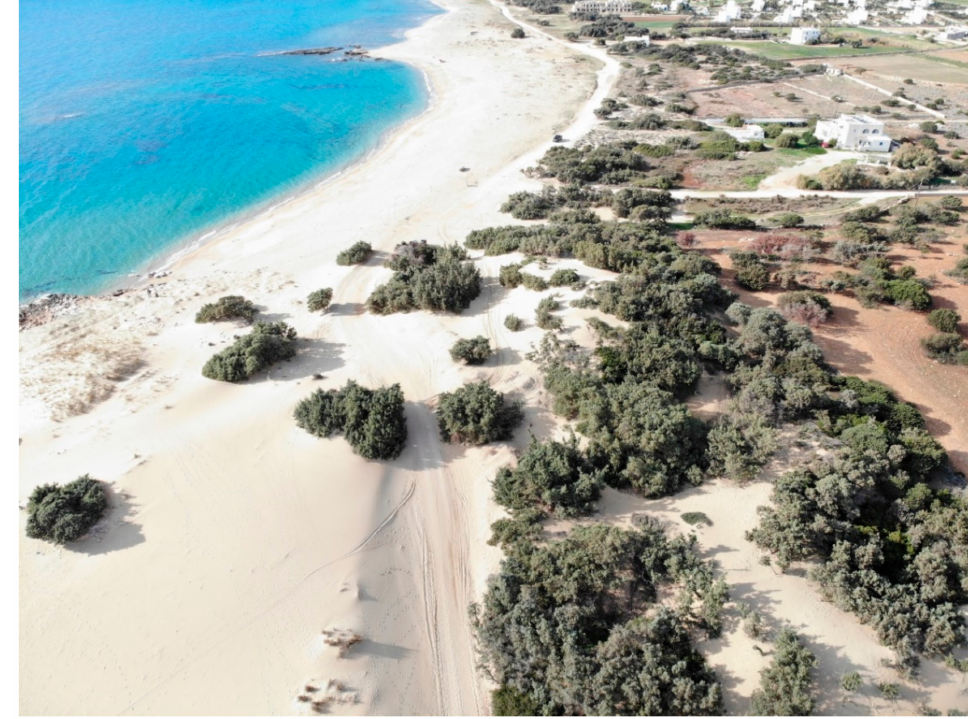
Figure 5. Characteristic dune fields in Naxos with cedar